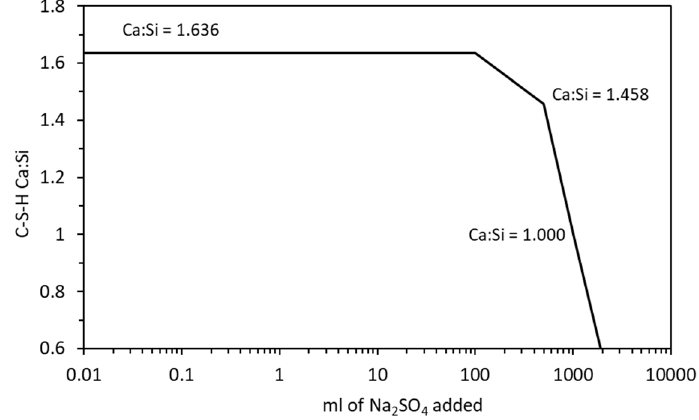
Figure 8. Change in C-S-H Ca:Si ratio with increasing sodium sulfate exposure.